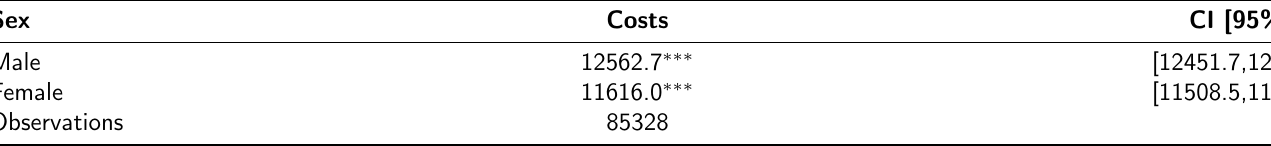
Supplementary Table 2: Univariate analysis GLM – Gender (margins for readability)